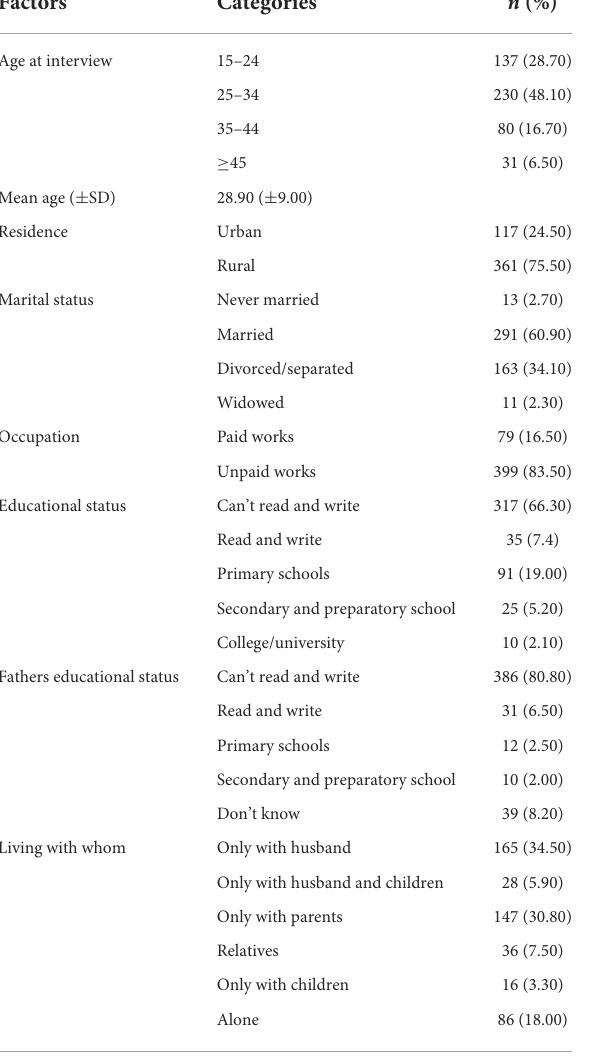
TABLE 2 Reproductive health history of women with fistula in Ethiopia, 2019 ( n =